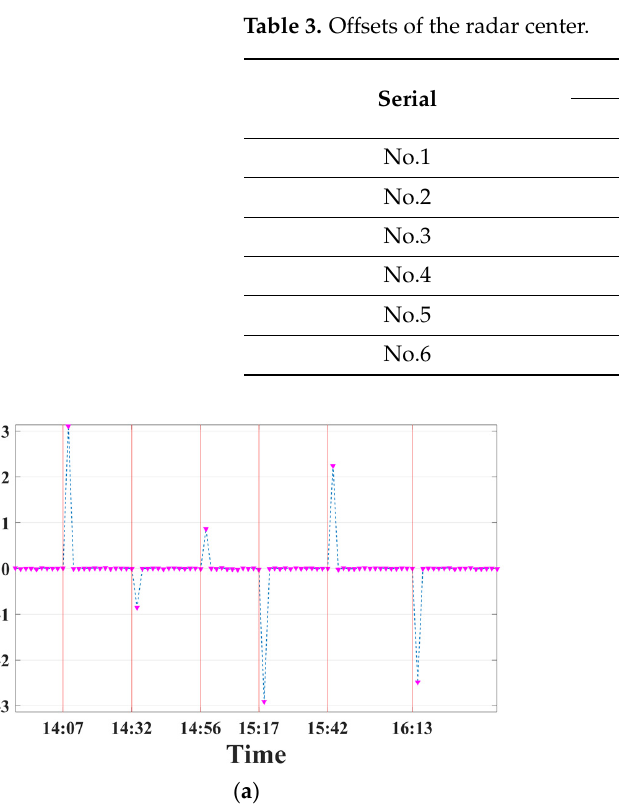
Figure 8. Interferometric phases of both corner reflectors (CRs): ( a ) CR 1 ; ( b ) CR 2 .